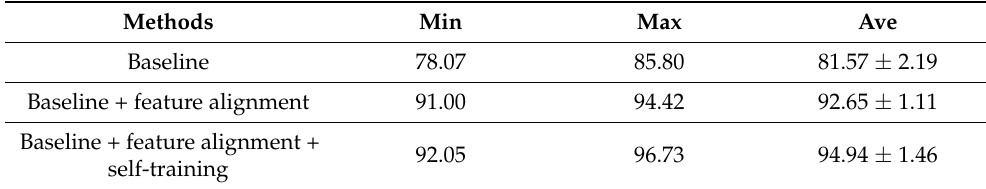
Table 5. Training Scenario I: recognition results in different stages of gradual domain adaptation recognition framework (%).